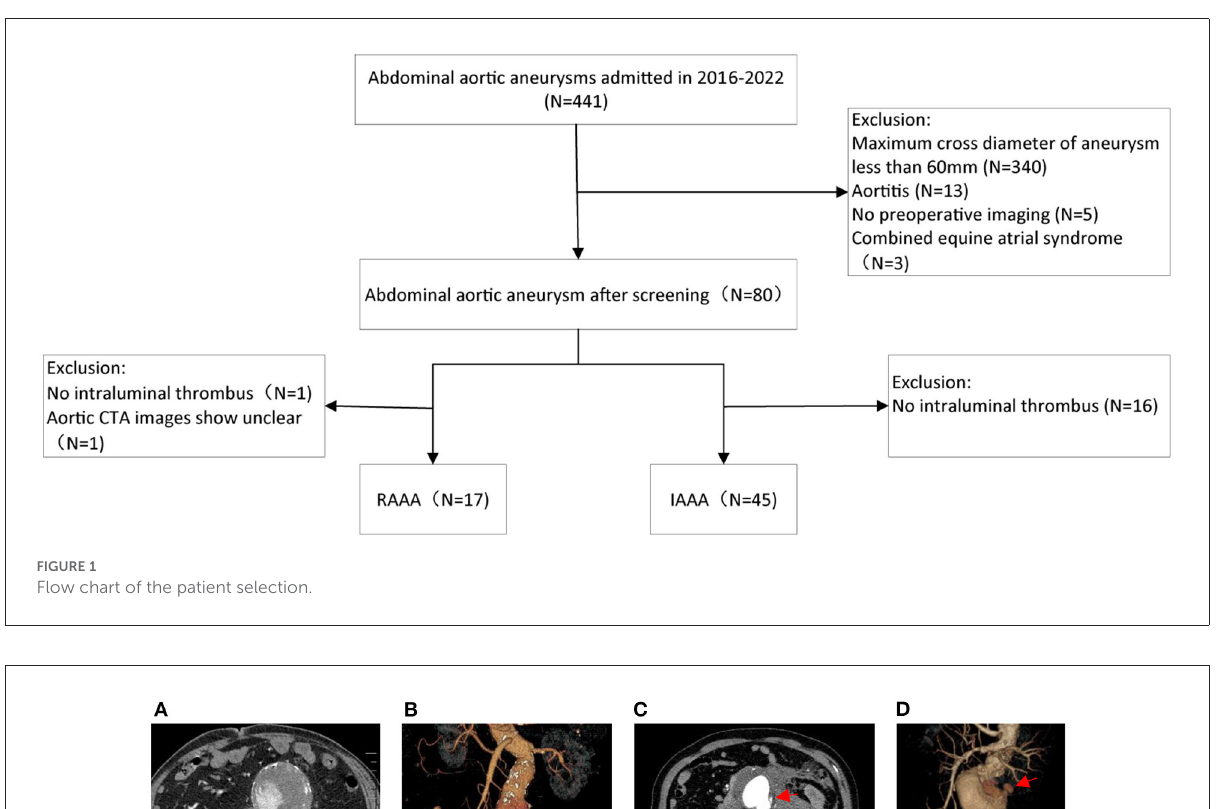
FIGURE2 MSCTA images of intact and ruptured abdominal aortic aneurysms. (A) shows the cross-section image of the intact abdominal aortic aneurysm. (B) shows the three-dimensional image of the intact abdominal aortic aneurysm. (C) shows the cross-section image of the ruptured